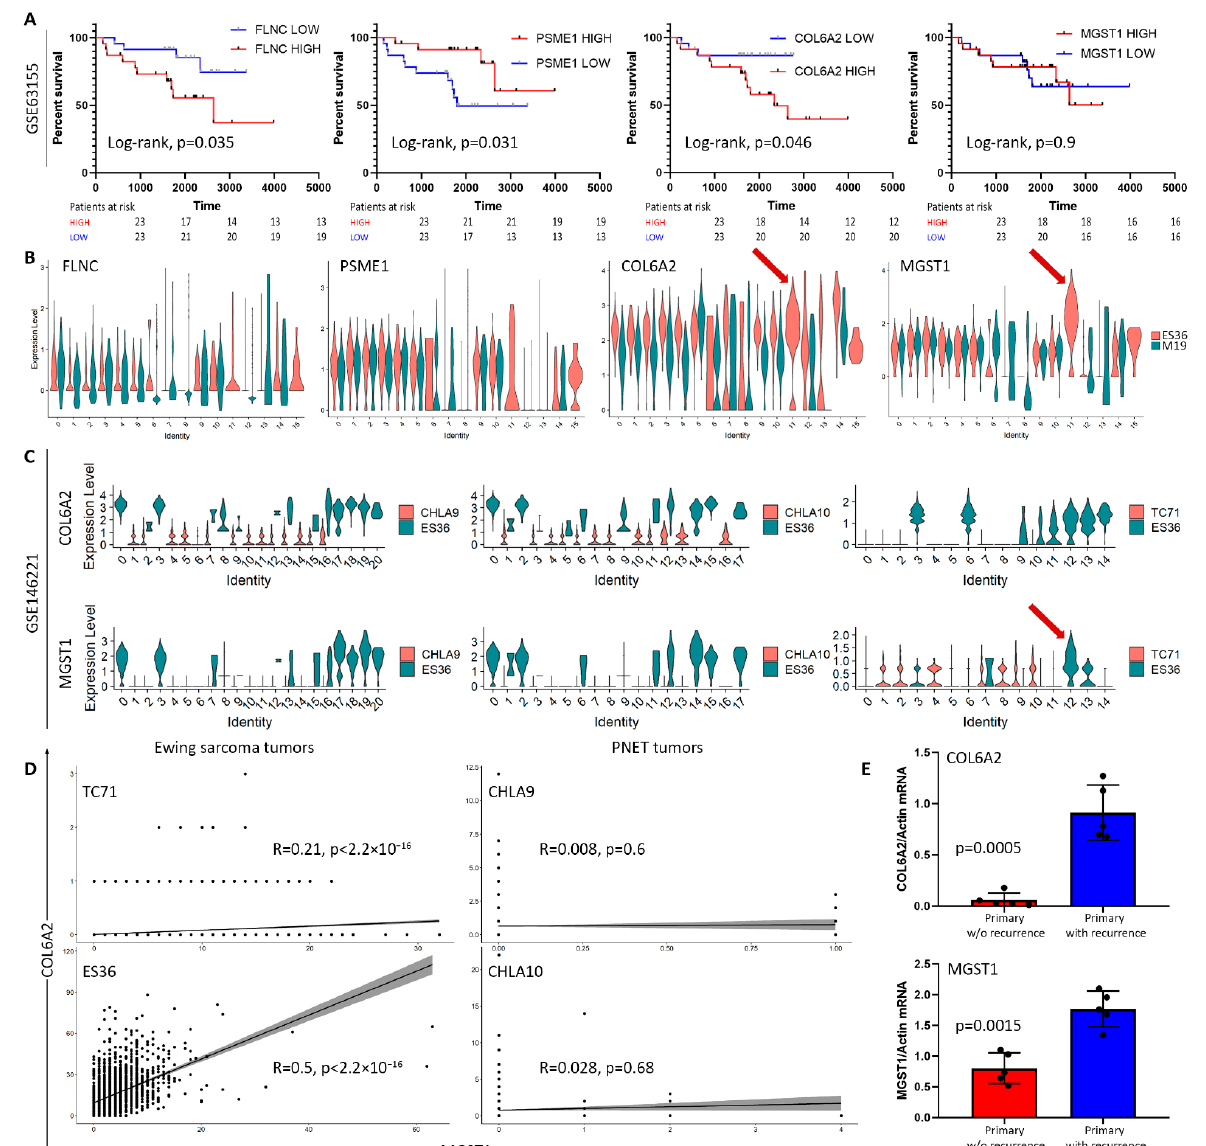
Figure 5. Validation of COL6A2 and MGST1 as markers for ES resistance and progression. ( A ) Group of 46 patients with ES was divided based on their marker expressions. Kaplan–Meier plot of OS for ES patients (GEO datasets GSE63155) stratified by transcriptomic data. The p -value was calculated using a two-sided log-rank test. ( B , C ) Single-cell RNA sequence discriminates a subset of tumor cells enriched with COL6A2 and MGIST1 markers across subclusters at ES36 and M19 cells ( B ) and in comparison with cellular subsets from TC71, CHLA9, and CHLA10 ( C ) (GEO dataset GSE146221). Data presented as violin plots are based on relative mRNA expression and clusterization of TC71, CHLA9, and CHLA10 with ES36 cells. Blue and black arrows indicate the association of MGST1 and COL6A2 with cluster 11 of ES36 cells. ( D ) Correlations between COL6A2 and MGIST1 expression in various ES cells. A significant positive correlation between COL6A2 and MGIST1 mRNA expression was detected in relapsed ES-based patient-derived cells and no such correlation was seen in PNET was considered significant. ( E ) mRNA levels of MGST1 and COL6A2 in selected primary patient samples (with/without recurrence, based on clinical information available) obtained from Federal State Budgetary Institution National Medical Research Center of Oncology named after N.N. Blokhin of the Ministry of Health of Russia. Semiquantitative PCR analysis of copy numbers of MGST1 and COL6A2 mRNAs obtained from absolute quantification using after normalization to b-actin. An unpaired t-test with Welch’s correction, p -value difference between groups is